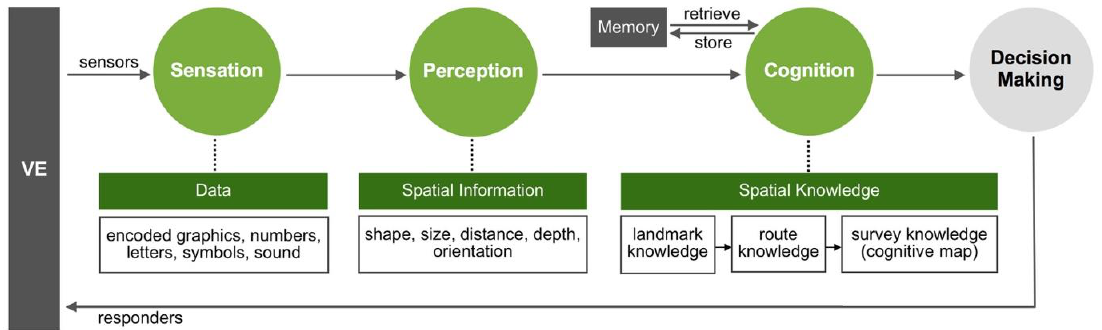
Figure 1. The human information-processing stages regarding the navigation in virtual environments.